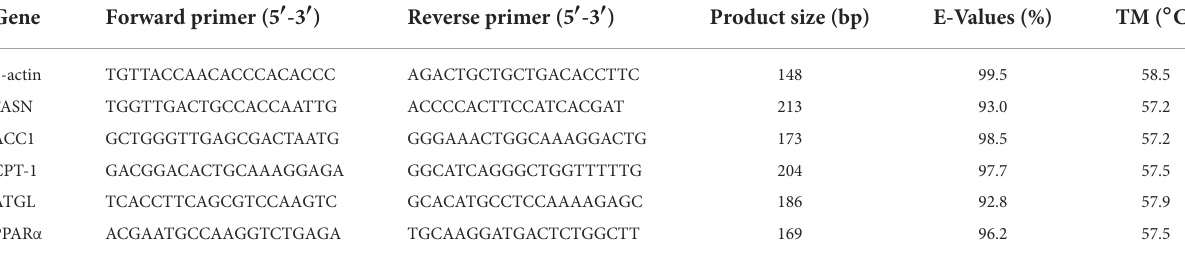
TABLE 1 Primer sequences for real-time